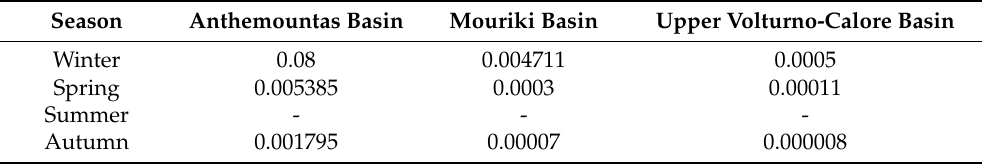
Table 3. Mean values of the SD from the GLDAS dataset for the whole study period (1960–2021). These seasonal values are calculated from the average monthly